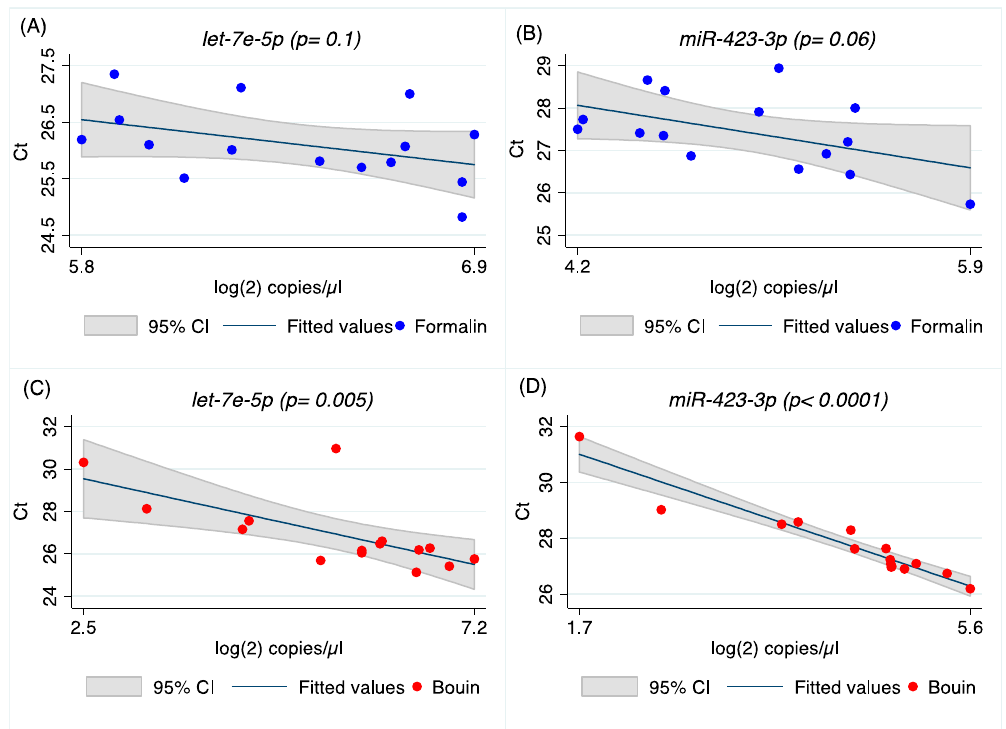
Figure 4. Scatter plot and linear prediction with 95% confidence interval of real-time and ddPCR